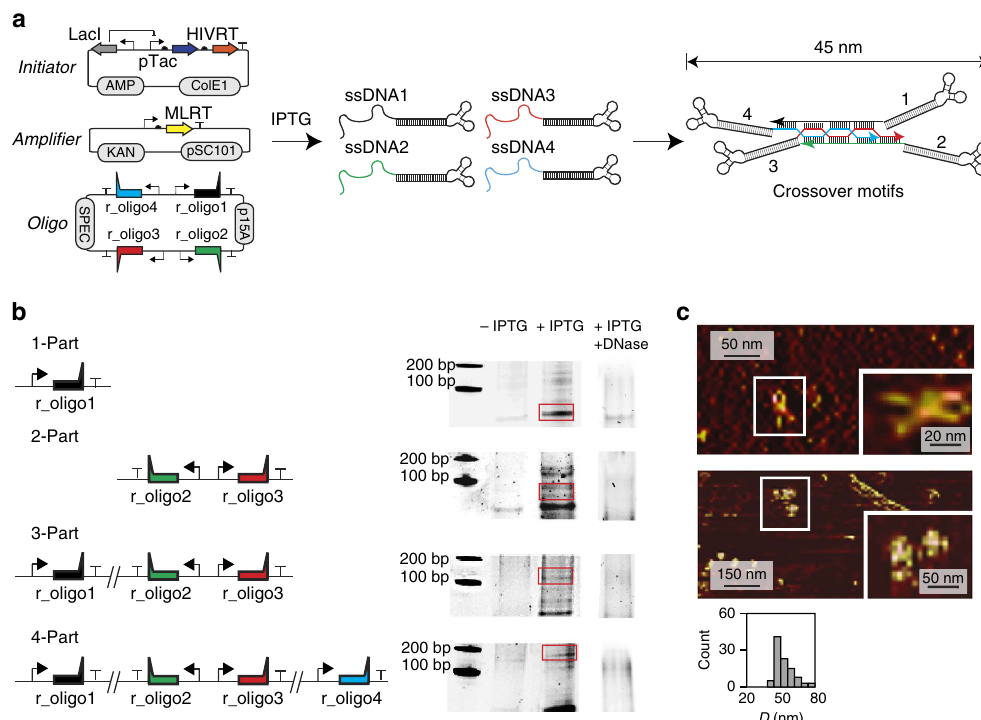
Figure 4 | In vivo production of DNA nanostructures. ( a ) The three-plasmid production system and the structure of the 4-part DNA nanostructure are shown. The nanostructure contains eight crossover junctions distributed among the four strands. The size was calculated using NuPACK 70 . The ssDNA sequences are added in Supplementary Table 2. ( b ) The production of DNA nanostructures and its intermediate elements are shown when different combinations of r_oligo genes are expressed in the presence of IPTG ( þ IPTG, 1mM) and the absence of IPTG ( (cid:2) IPTG) under conditions preserving the HTBS. The red bands show the approximate regions of the intermediate elements/DNA nanostructures ( þ IPTG/ þ DNase). Representative samples inducing the HIVRTand expressing the different r_oligo genes but exposed to DNase condition (the complete gel is shown in Supplementary Fig. 7). Insert: Zoom-in. ( c ) AFM images of the 4-part DNA nanostructure excised and purified from its appropriate band (as shown in b , the red square in the bottom gel). The size of the DNA nanostructure ( D ) in the form of a histogram is shown. The histogram has been calculated by auto-selecting all the particles with a minimum height of 0.5nm and a maximum of 5nm from the AFM images (Methods). For more AFM images, see Supplementary Fig.